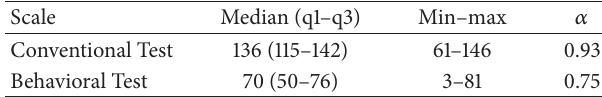
Table 4: Descriptive data on scales and reliability ( 𝑛 = 75 ). Table 5: Comparison of groups of patients with and without USN ( 𝑛 = 75